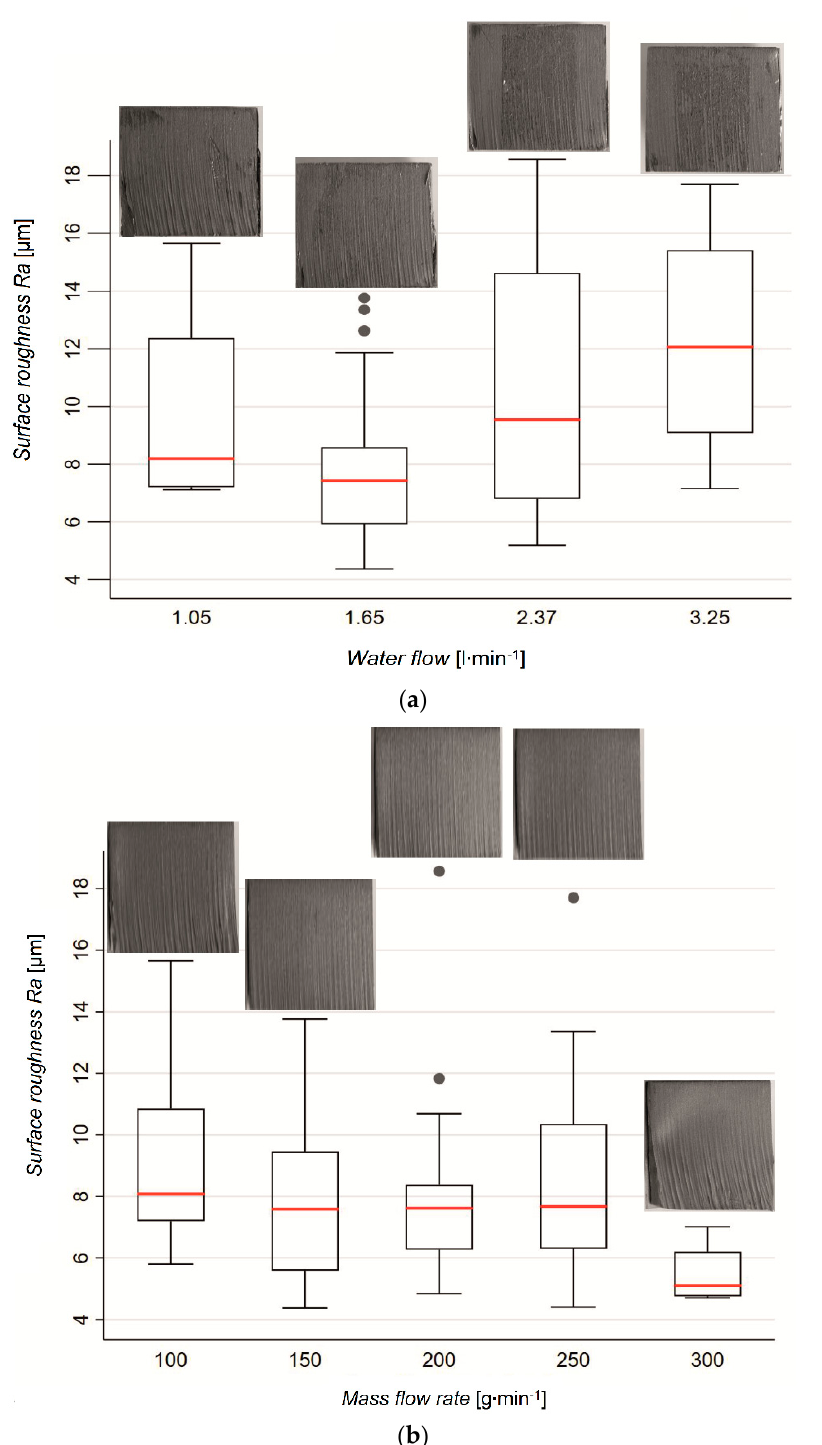
Figure 5. Effect of high-pressure water flow ( a ) and abrasive mass flow ( b ) on the change in surface roughness value Ra .